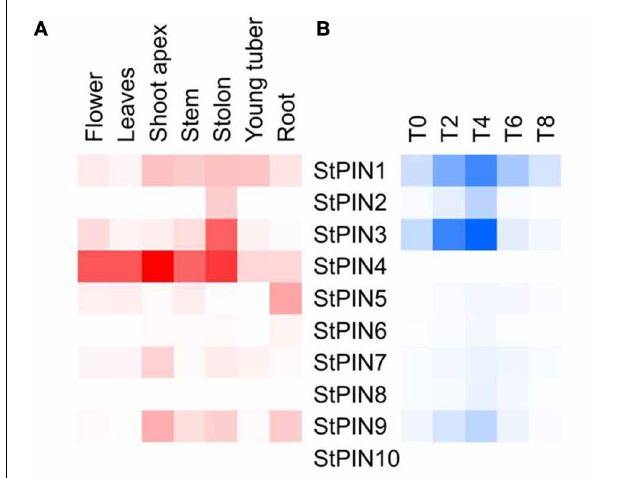
FIGURE 3 | Heat map of expression of the StPIN genes in the corresponding tissues according to the RNA-seq data of RH and in the tuber developmental series (time points T0 to T8). In (A) , expression levels in the various tissues are indicated by shades of red, where white indicates no expression. In (B) , for stages T0 to T8 of the developmental series, 0 to 8 days after induction to tuberise, shades of blue represent fold increase in the expression of the corresponding gene and white indicates the lowest expression detected. Lowest expression is detected for StPIN10 at stage T4 ( C ( t ) = 36 . 29), and highest expression is detected for StPIN1 at stage T8 ( C ( t ) = 25 .